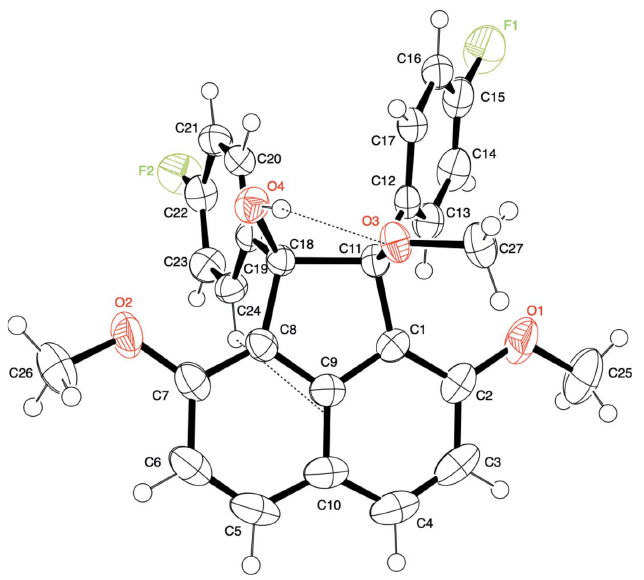
Figure 1 The molecular structure of the title compound, with atom labelling and intramolecular O—H (cid:2)(cid:2)(cid:2) O and C—H (cid:2)(cid:2)(cid:2) (cid:2) contacts (dashed lines). Displacement ellipsoids are drawn at the 50% probability